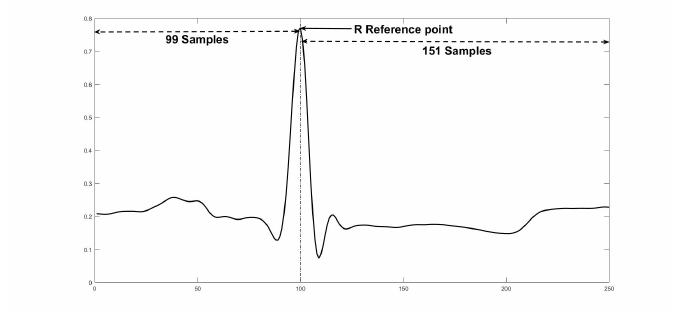
Figure 6. Heartbeat segmentation